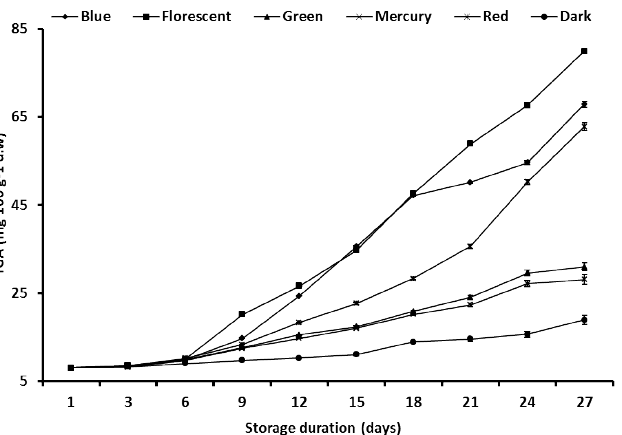
Fig. 7: Effect of different light sources on total phenolic content. Vertical bars show ±SE of means (n=3). Interaction between storage duration and light sources was significantly different at p ≤